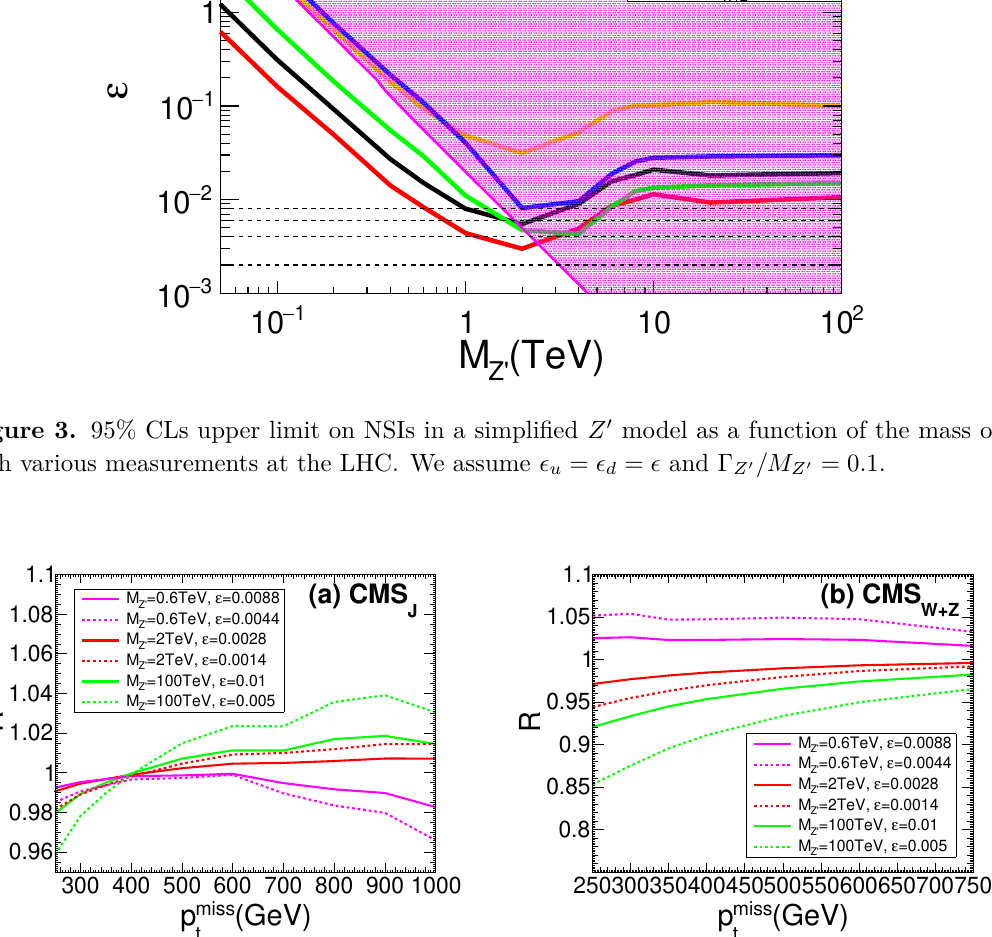
M = 2 TeV, the value of ( | (cid:15) + | − | (cid:15) − | ) / | (cid:15) + | is about 0.5%. The impact of Z 0